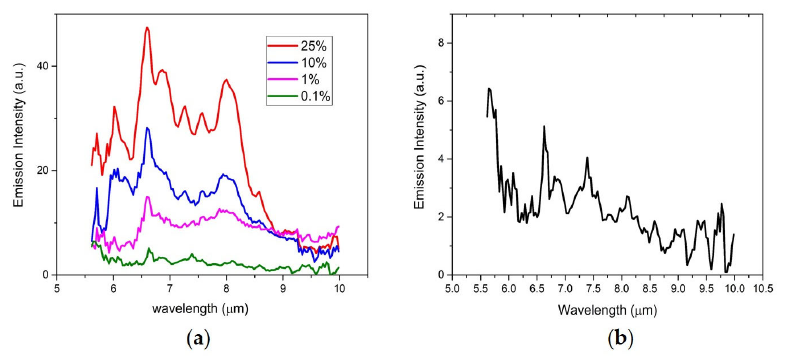
Figure 8. ( a ) LWIR spectra of four acetaminophen/Al 2 O 3 mixture samples of different acetaminophen concentrations after removing the background substrate emissions. ( b ) LWIR LIBS spectra of the 0.1% weight acetaminophen/Al 2 O 3 mixture sample after removing the background substrate emissions.